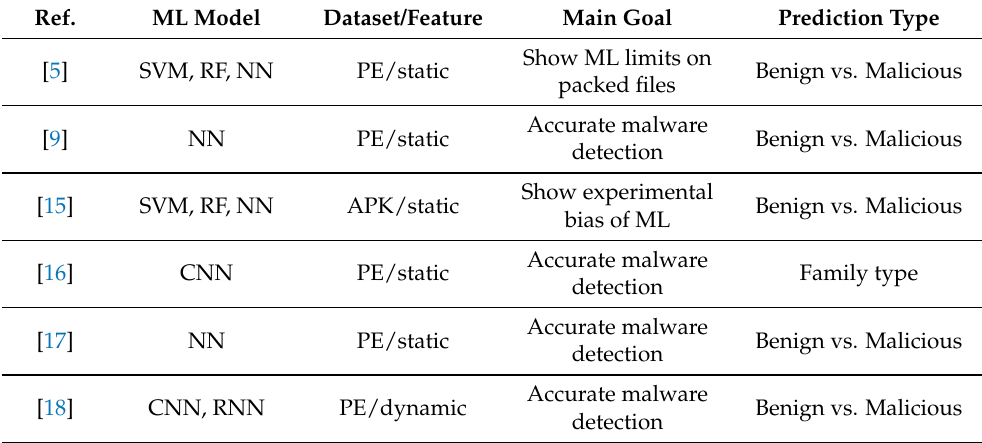
Table 1. Summary of related